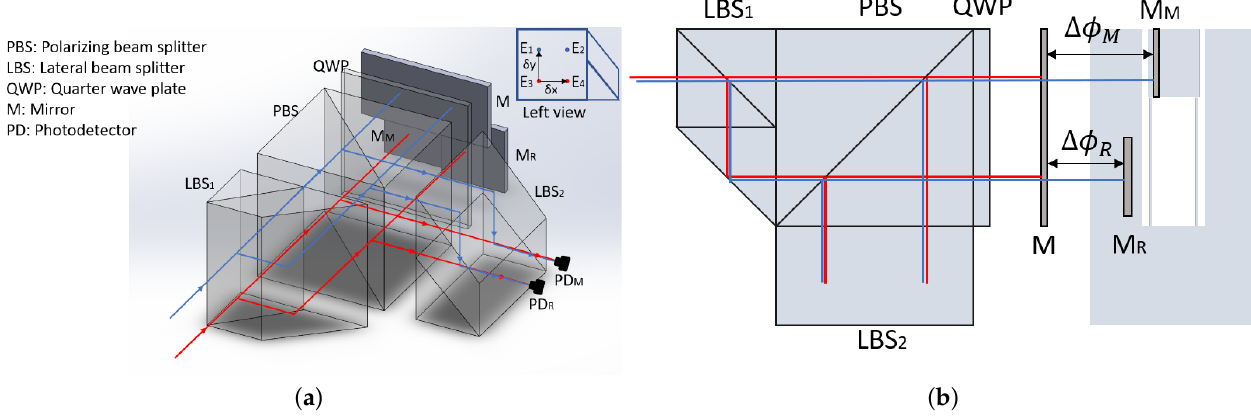
Figure 1. ( a ) The layout of the compact benchtop heterodyne laser interferometer design; ( b ) top view of the layout. Two laser beams with different frequencies enter the lateral beam splitter (LBS) and split into four beams, constructing two interferometers measuring interferometer (MIFO) and reference interferometer (RIFO). The MIFO is to measure the optical pathlength difference (OPD), ∆ φ M and the RIFO is to measure ∆ φ R . The actual displacement of test mass M M is calculated from the differential measurement between MIFO and